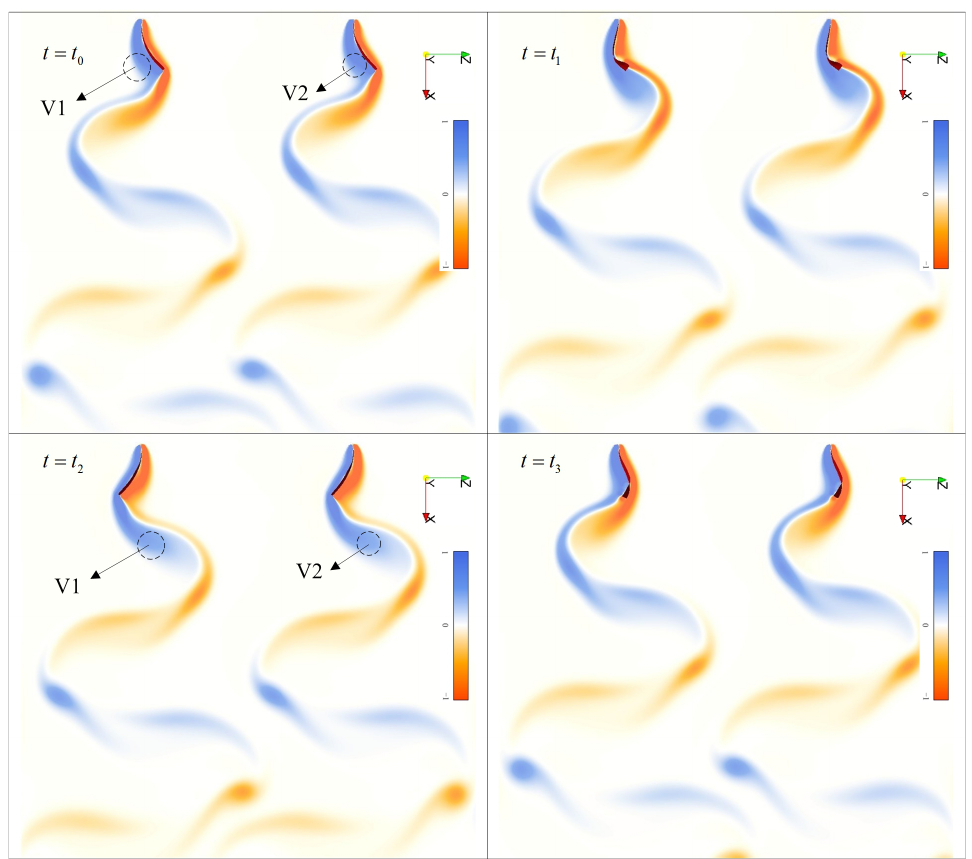
Figure 16. Time evolutions of the vortical structures of two side-by-side flapping plates at G z =